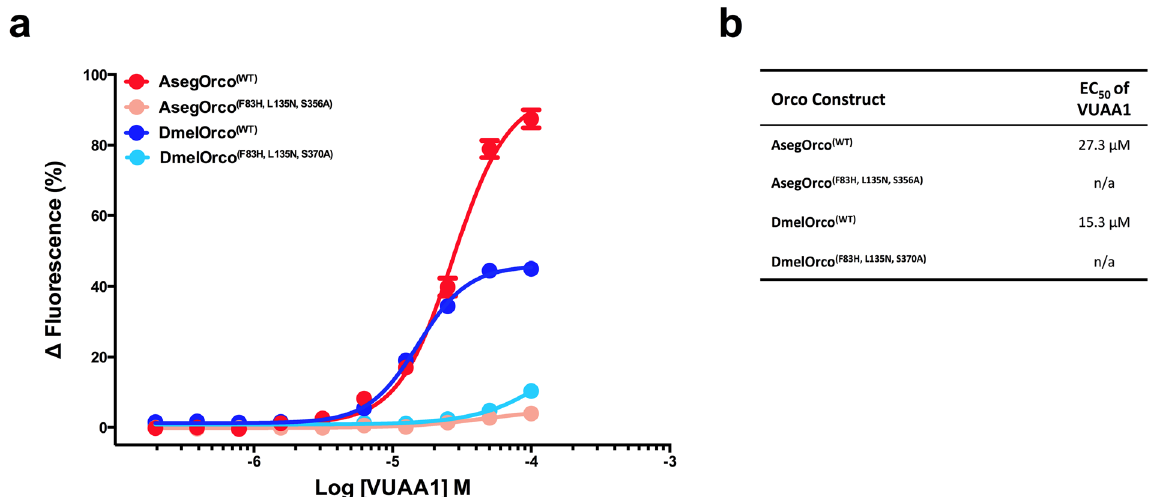
Figure 3. ( a ) Response of TREx/HEK293 cells expressing wild-type or mutated forms of Agrotis segetum (Aseg) and Drosophila melanogaster (Dmel) Orcos to different concentrations of the Orco agonist VUAA1. ( b ) EC 50 values for the responses shown in ( a ). Data represent the mean response ( ± SEM) of cells from three biological replicates. Note: all data points contain error bars; some are too small to be